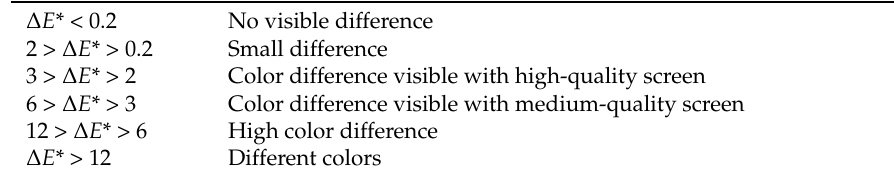
Table 2. The scale of ∆ E * [24].